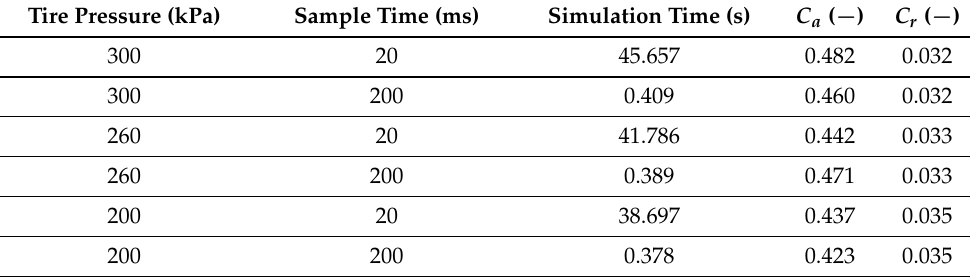
Table 1. Aerodynamic and rolling resistance coefficients of the Biro electric car.